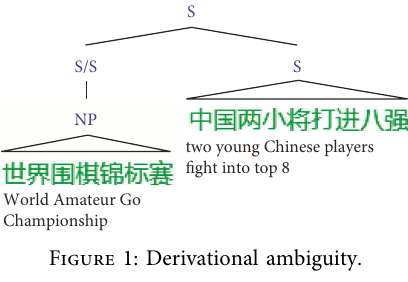
Figure 1: Derivational ambiguity.